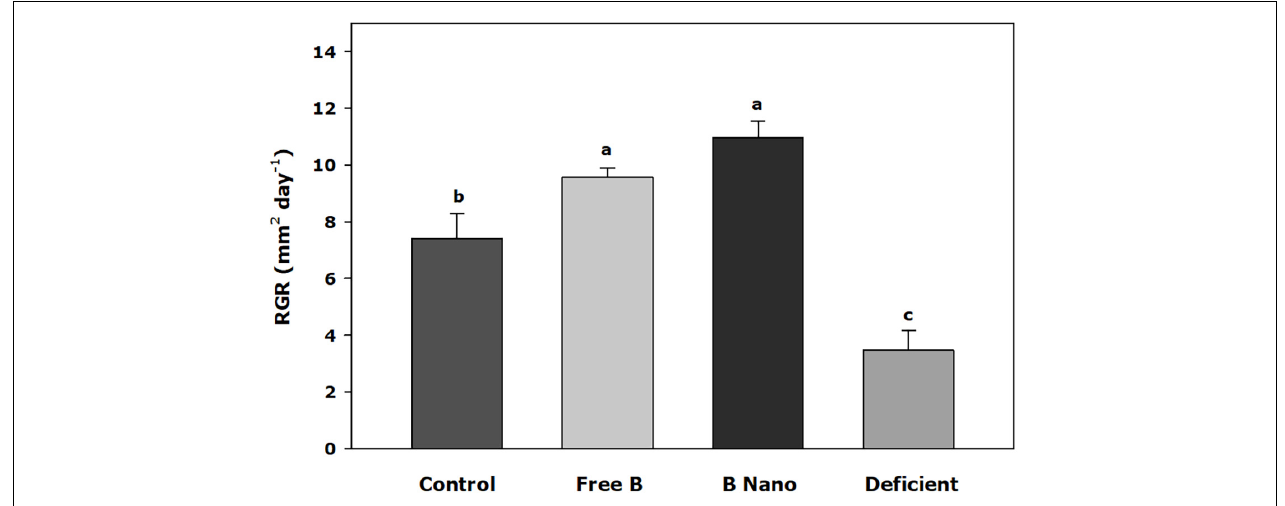
FIGURE 1 | RGR of the youngest leaves 7 days after the foliar application of boron (B). B Nano, Nanoencapsulated B. Values are means ± SE ( n = 8). Two independent experiments have been carried out. Columns with different letters differ significantly according to Duncan’s test ( p <